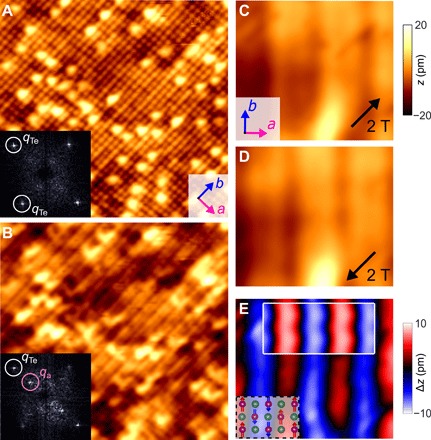
Spin-polarized STM of Fe1.06Te.(A) Topographic STM image taken with a nonmagnetic tip (14.5 by 14.5 nm2). Protrusions are excess Fe atoms. Inset: Fourier transform (FT) image of (A). Peaks that arise from the Te lattice are highlighted with solid circles. (B) Topographic SP-STM image taken at the same position as (A) with a magnetic tip. Stripes arise from the AFM order. Inset: FT image of (B) showing additional peaks due to the AFM order. (C and D) Topographic SP-STM images taken at the same position with the tip polarized along two opposite in-plane directions (1.9 by 2.6 nm2). Tunneling parameters for (A) to (D): V = 100 mV, I = 50 pA. (E) Difference image of (C) and (D). The height difference is proportional to the spin polarization of the tunneling current. Inset at the bottom left: Structural model of the Fe1+xTe surface, showing the spin order in the Fe lattice (red). Inset at top right: DFT calculation of the magnetic contrast due to the spin polarization at the Fermi energy (see section S1).